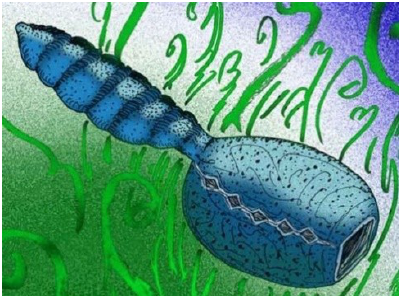
Figure 10. Ooedigera . Length of animal 4.2 cm. PaleoArt credit: Apokryltaros. Used here per CC BY- SA 3.0.